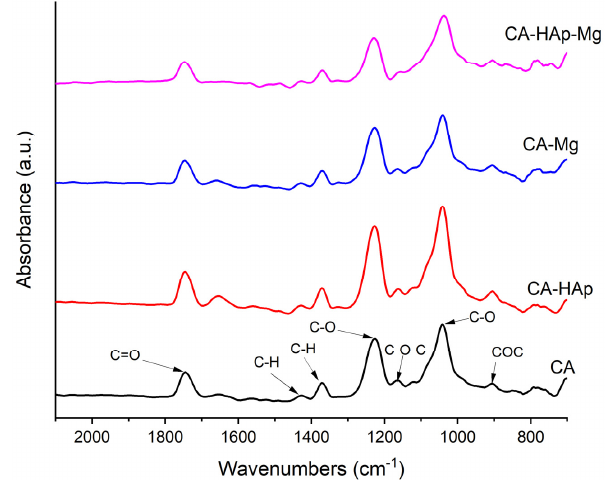
Figure 6. FTIR spectra of the experimental samples (CA, CA-HAp, CA-Mg, and CA-HAp-Mg). The spectra of the composite samples (CA-Mg, Ca-HAp, and CA-HAp-Mg samples) are almost similar to the spectrum of cellulose acetate. The band corresponding to the C-O bond from 1040 cm − 1 shifts to the right in the case of composite samples (CA-Hap and CA-HAp-Mg) due to the influence of the PO 43 − groups from hydroxyapatite, which appear in the same region of the spectrum. In the FTIR spectra of the composite samples, there are no two distinct bands for C-O and P-O bond vibrations, due to the small number of inorganic particles contained in and overlapping the vibration bands characteristic of hydroxyapatite in the range of 600–1100 cm − 1 with the corresponding polymer bands.